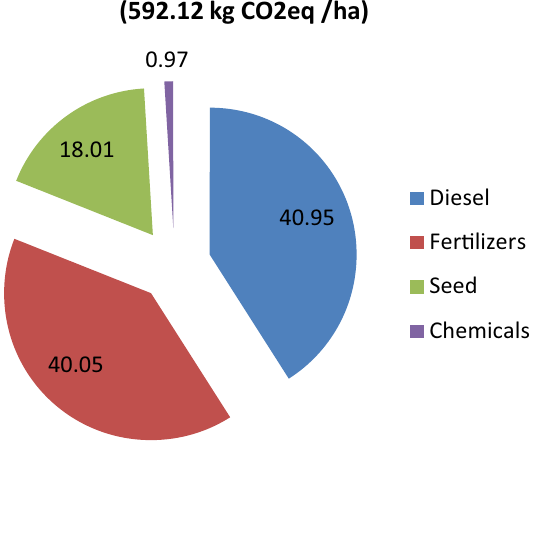
Fig. 1 Percentage distribu- tion of the share of different energy inputs in total GHG emissions for wheat